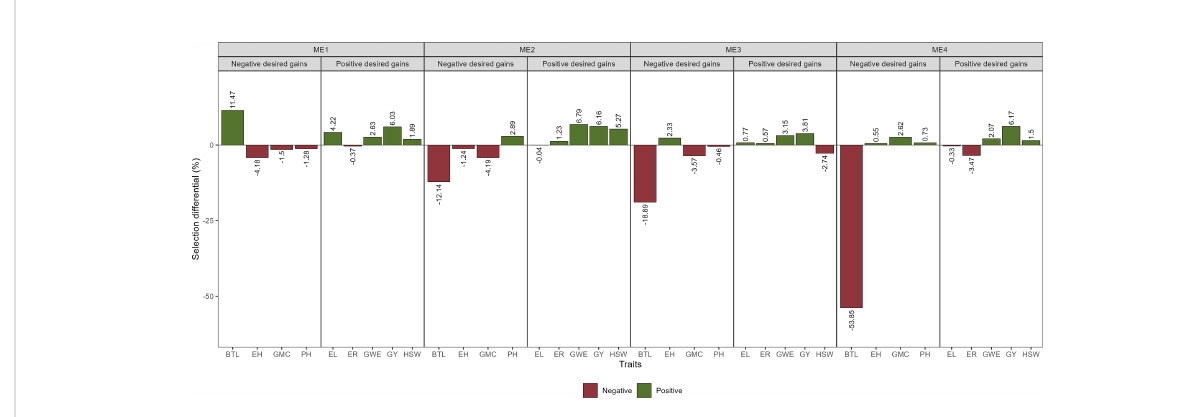
FIGURE 8 Selection gains for mean performance considering the selection within each ME.